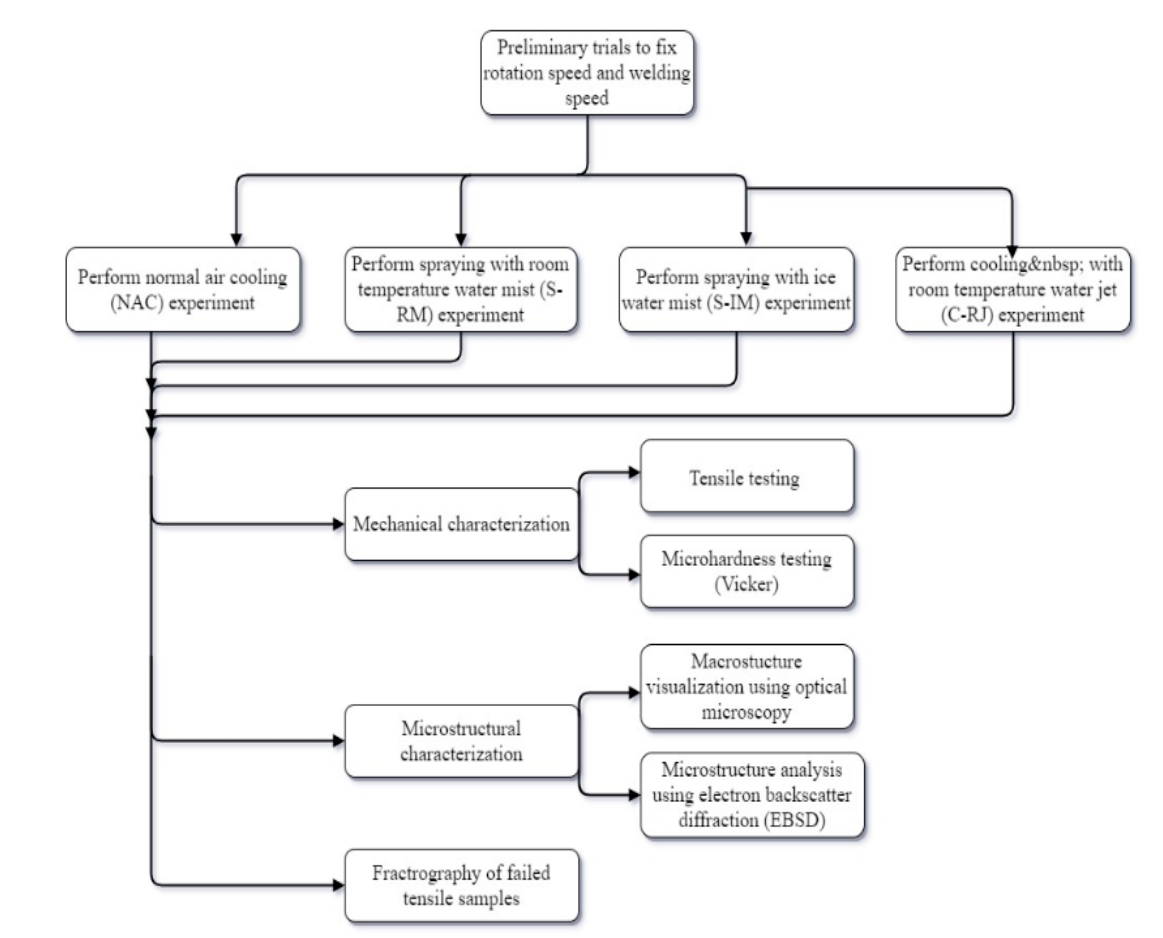
Figure 3. Flow-chart of the adopted methodology.